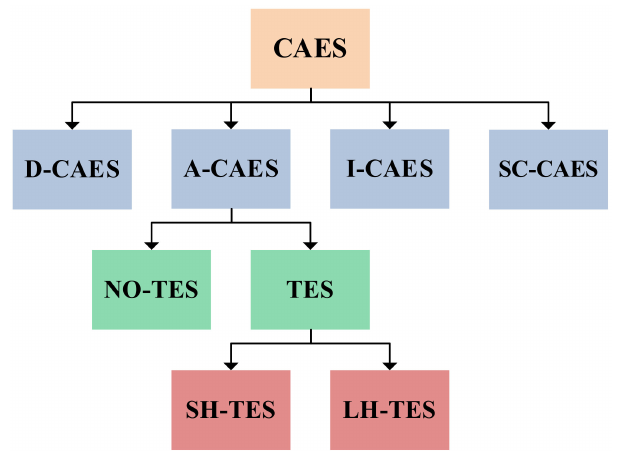
Figure 3. Classification of compressed air energy storage